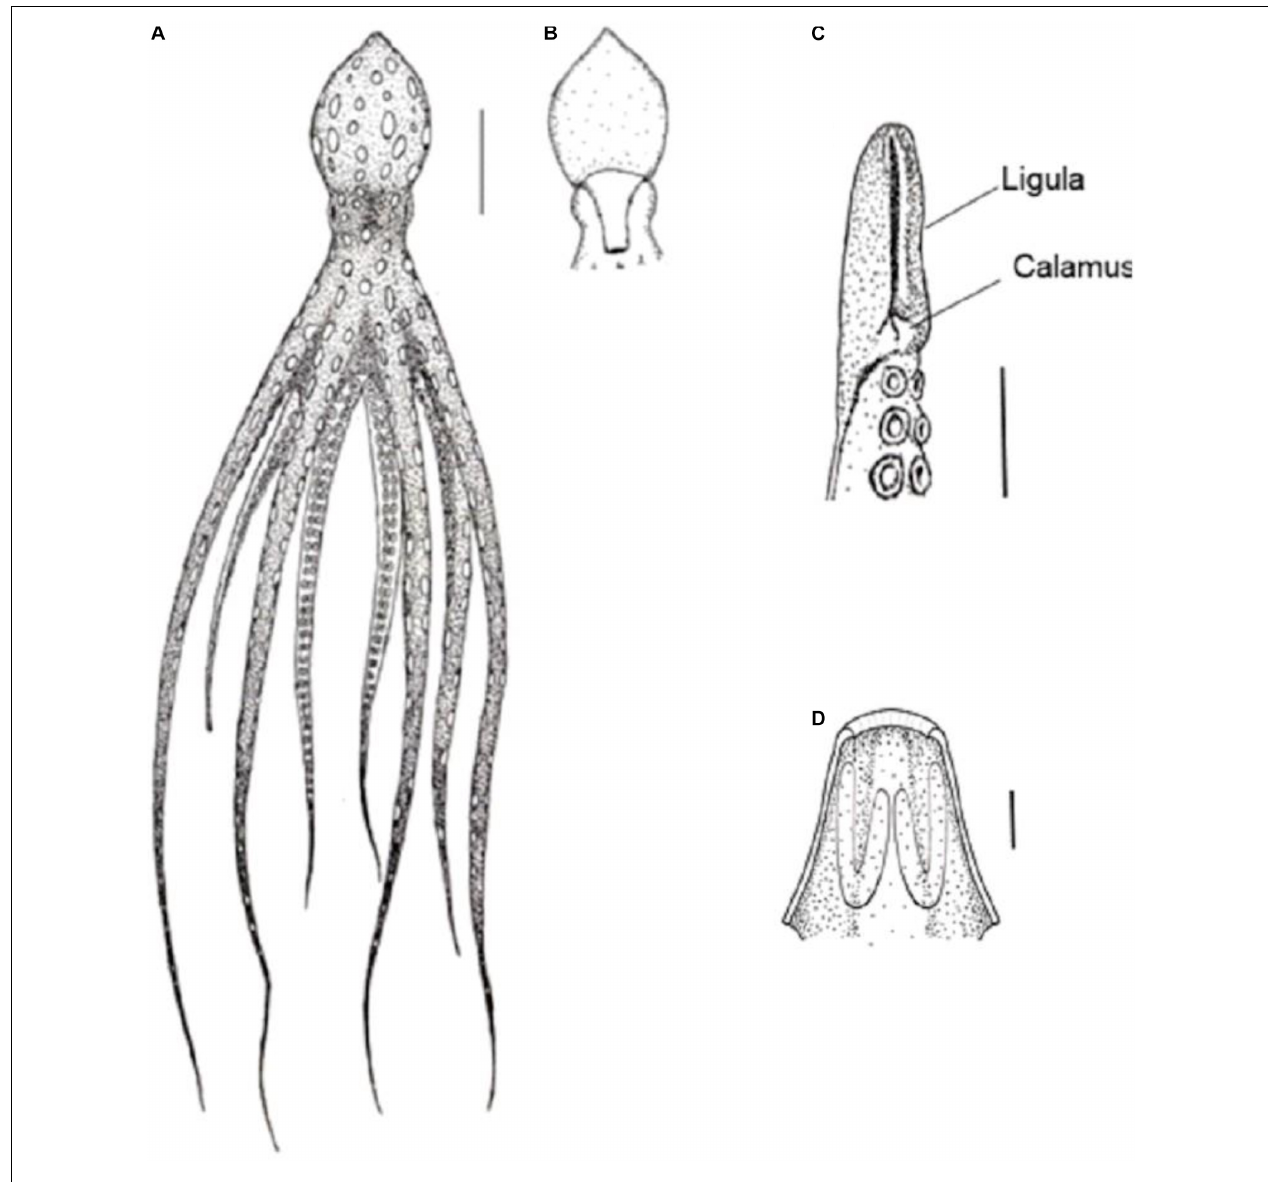
FIGURE 2 | Callistoctopus furvus . (A–C) Neotype (95 mm ML MZUSP 152154); (D) Voucher specimen (85 mm ML NHMUK 20200278). (A) Dorsal view. (B) Ventral view (mantle). (C) Copulatory organ (ligula and calamus) on tip of right third arm. (D) Funnel organ on dorsal surface of funnel. Scale bars: (A,B) = 50 mm, (C) = 5 mm, (D) = 10